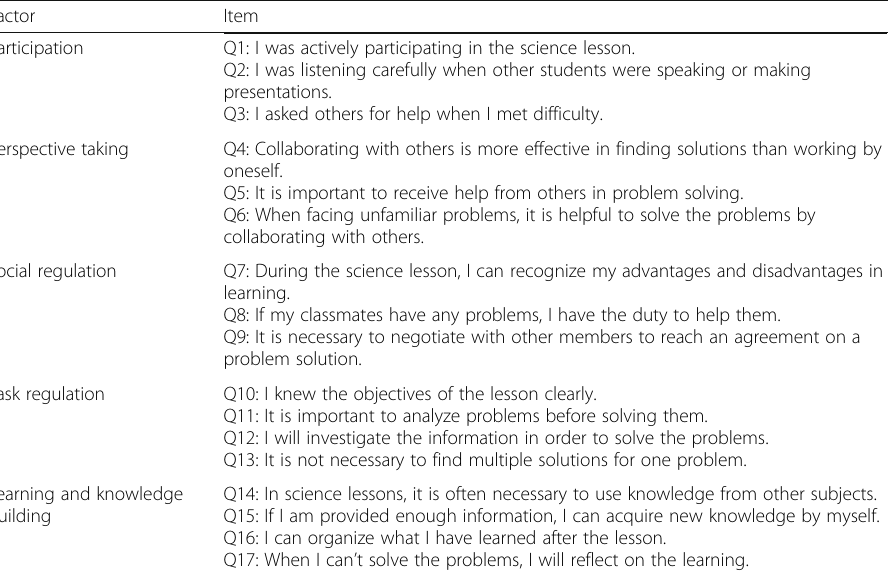
Table 10 Items of the Collaborative Problem Solving (CPS)